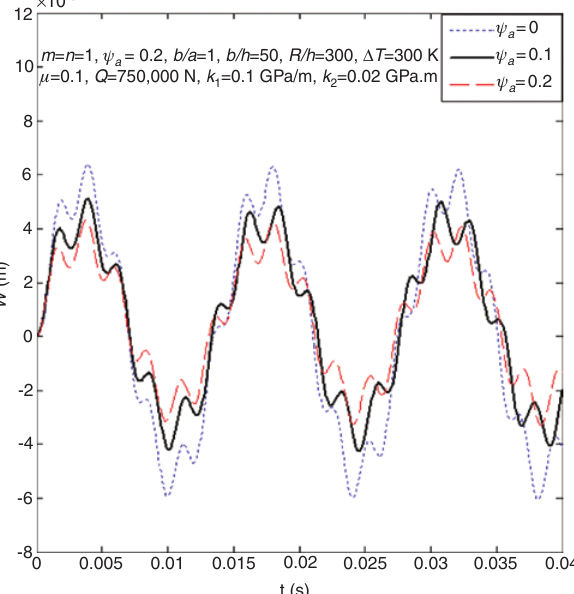
Figure 3: Effects of the fibre volume fraction ψ response of the three-phase laminated polymer composite cylindri- cal panel.